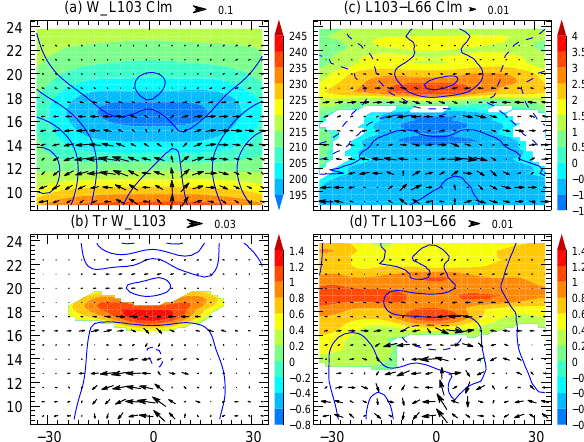
Figure 9. (a) Annual mean climatological zonal mean zonal wind (contours; contour interval is 10ms − 1 ; dashed lines indicate east- erly winds), BDC vector (arrows, scaled with the square root of pressure) and temperature (colour shadings) for the W_L103 exper- iment from 8 to 25km and 35 ◦ S through 35 ◦ N. (c) Differences of the zonal mean zonal wind (contour interval 1.0ms − 1 ), BDC vec- tor and temperature (colour shadings indicate 95% statistical sig- nificance) between the W_L103 and the W_L66 experiments. (b) and (d) are the same as (a) and (c) but for the linear trends from 2001 to 2010. The shadings in (b) and (d) indicate 95% statistical significance. The contour intervals are 2 and 1ms − 1 in (c) and (d)